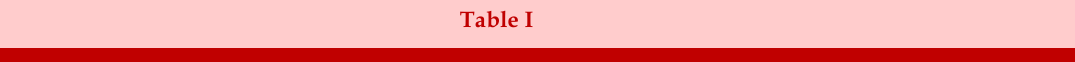
Constituents of essential oil from the leaf and rhizome of Zingiber cassumunar